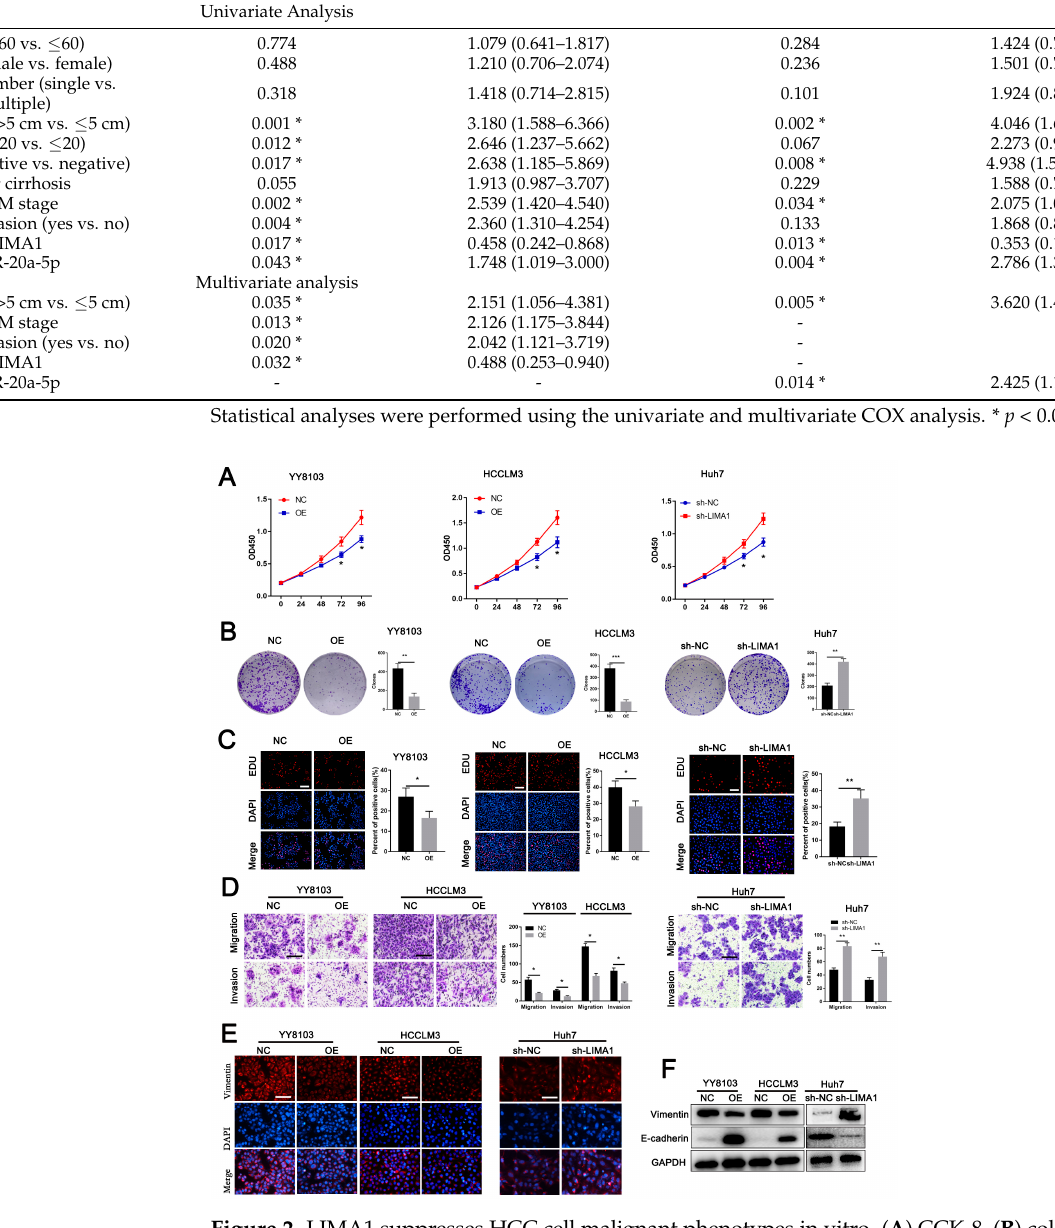
Figure 2. LIMA1 suppresses HCC cell malignant phenotypes in vitro. ( A ) CCK-8, ( B ) colony formation, and ( C ) EdU assays were performed to examine the effects of LIMA1 on proliferation. ( D )